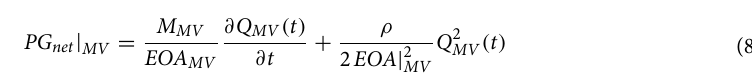
Figure 7. Grid convergence analysis. ( a ) TAWSS at the PVL location: TAWSS comparisons for different mesh resolutions at the peak of filling phase (maximum TAWSS): difference in peak TAWSS between mesh#3 and mesh#4 is 3% and between mesh#4 and #5 is 1.03%; ( b ) Von Mises stress: Von mises stress comparisons for different mesh resolutions of left coronary artery at the peak of filling phase: difference in maximum stress between mesh#3 and mesh#4 is 5.25% and between mesh#4 and #5 is 1.43%; (c) Plots for Maximum TAWSS and Maximum Von Mises stress versus the number of mesh